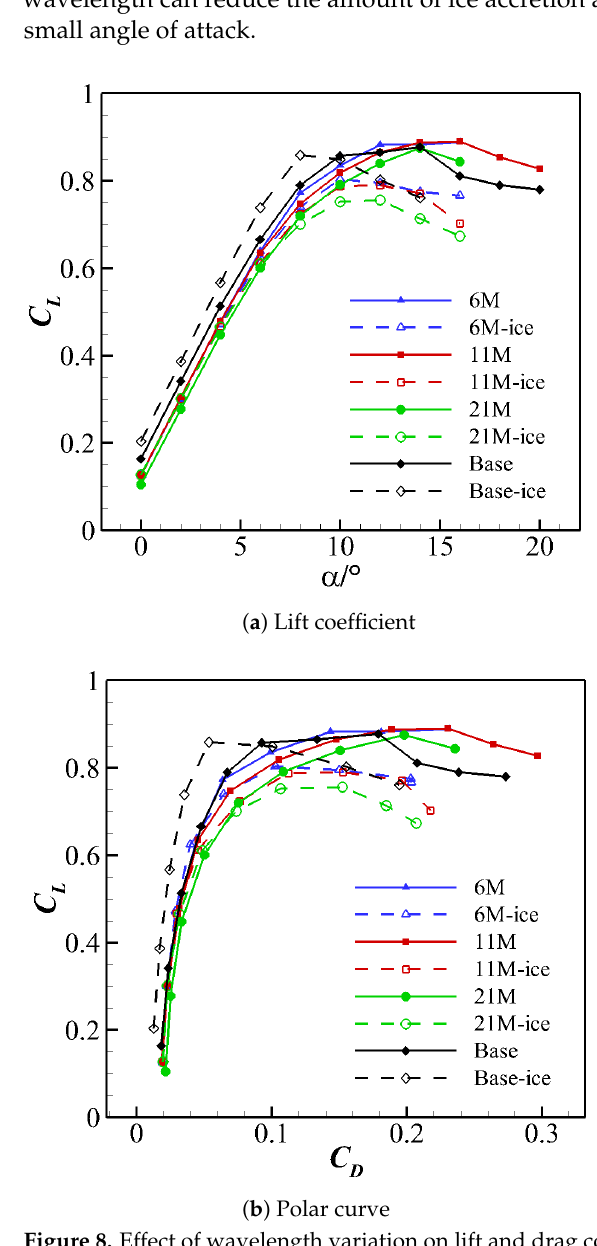
Figure 8. Effect of wavelength variation on lift and drag coefficients.